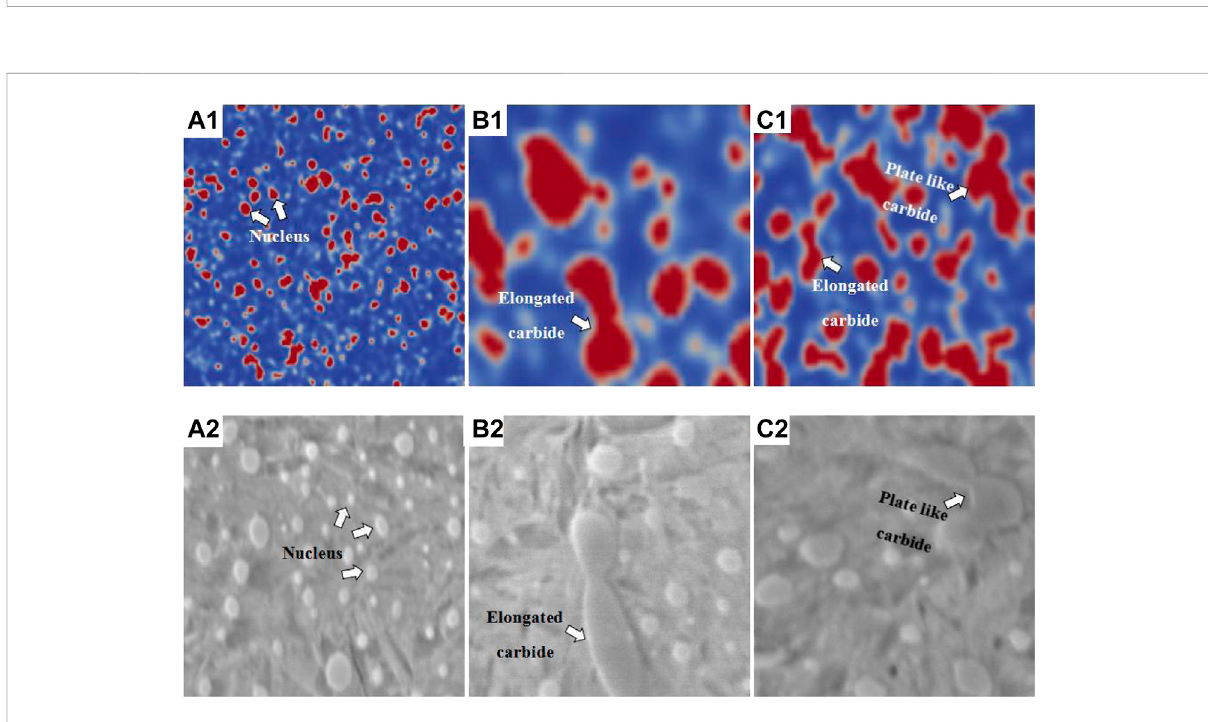
FIGURE 12 Comparison of phase- fi eld simulation results with SEM experimental